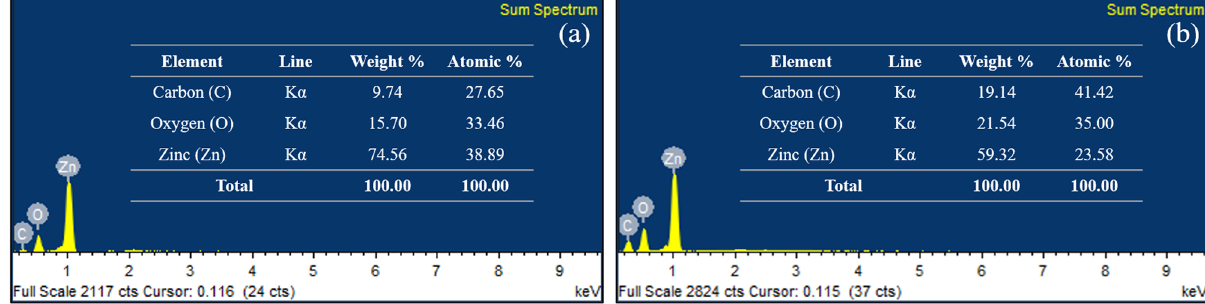
Figure 7: EDX spectra ( a ) ZnO Chem , ( b ) ZnO SMEAF with elemental weight and atomic distribution percentages ( inset )